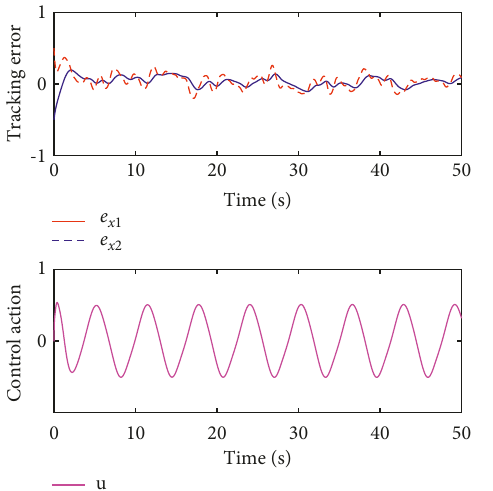
Figure 11: Tracking error and proposed control action with (21). Table 1: Dynamic parameters of 2-DOF robot. Symbol